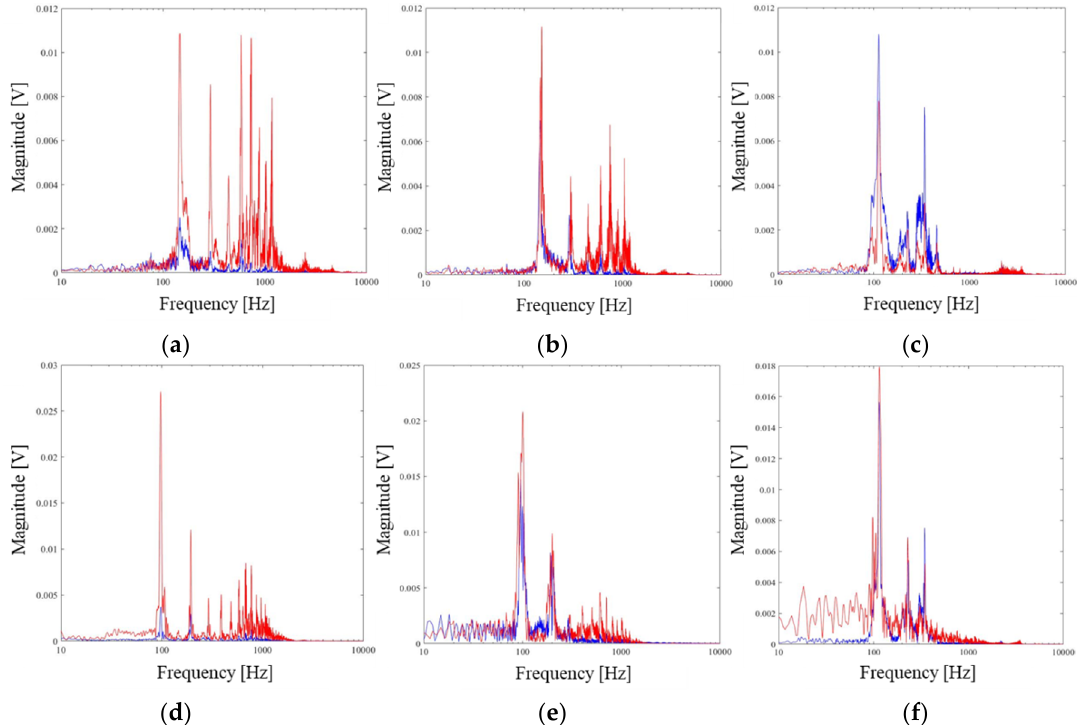
Figure 8. Measured spectrum of vocal signal of males using the separation-type structure for ( a ) / a / , ( b ) / mama / , and ( c ) / mimi / , and measured spectrum of vocal signal of males using the mask-type structure for ( d ) / a / , ( e ) / mama / , and ( f ) / mimi / (the red line is the microphone output in the oral direction and the blue line is the microphone output in the nasal